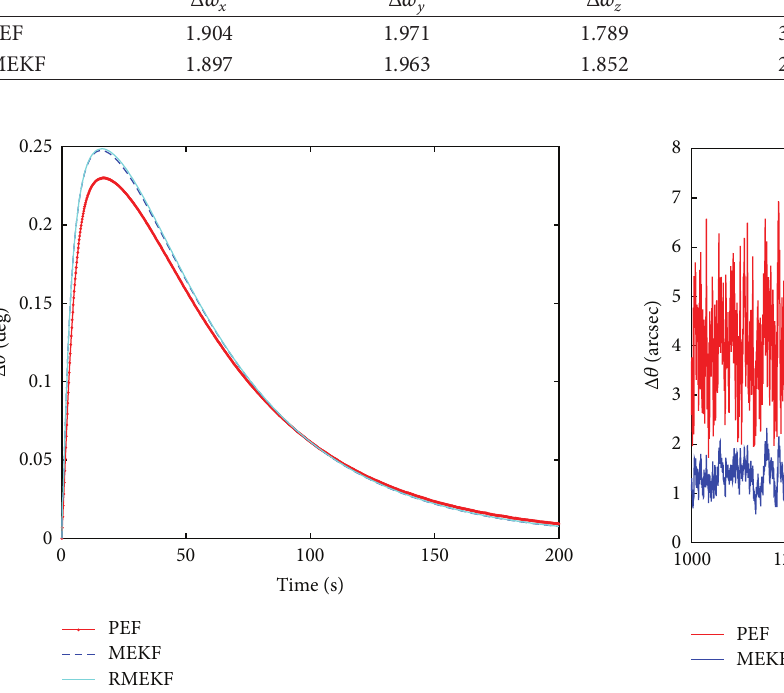
Figure 6: Steady attitude angle estimation